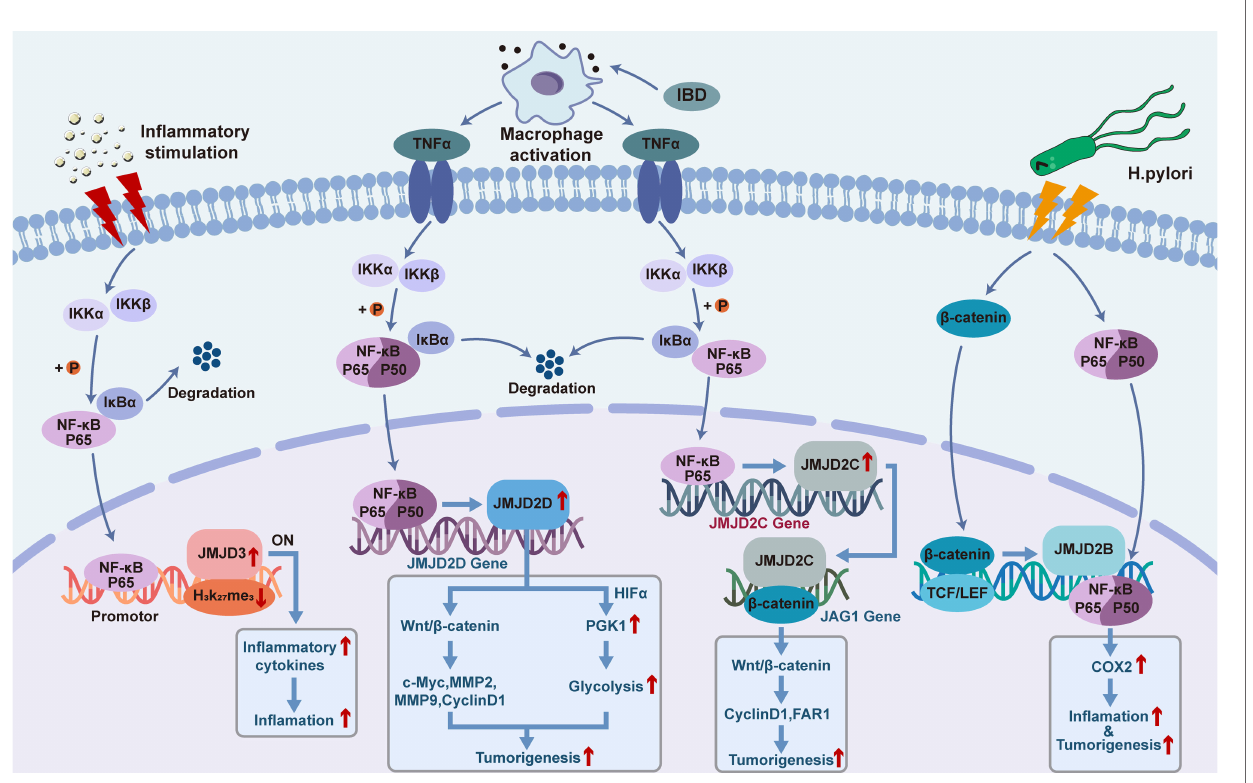
FIGURE 1 | Functional roles and mechanisms of JMJD2B/C/D and JMJD3 in the crosstalk between in fl ammation and